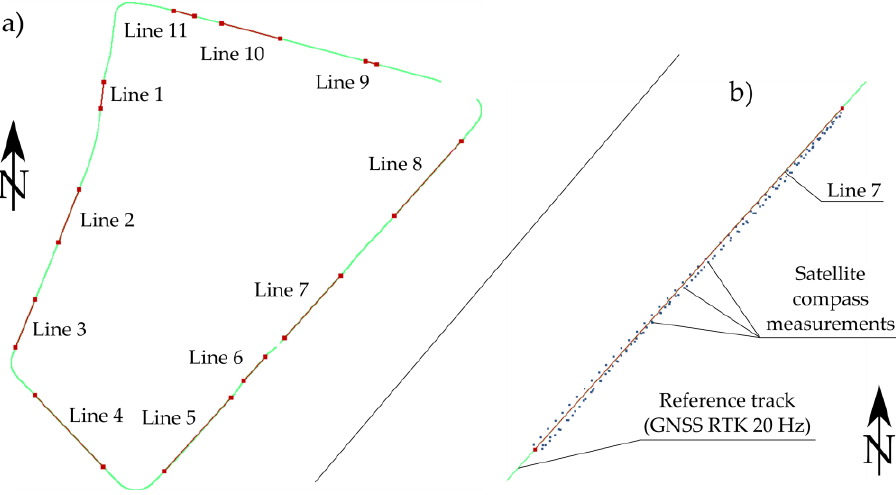
Figure 13. Eleven rectilinear control sections of the tram track axis ( a ) with detailed view of one of the lines ( b ).